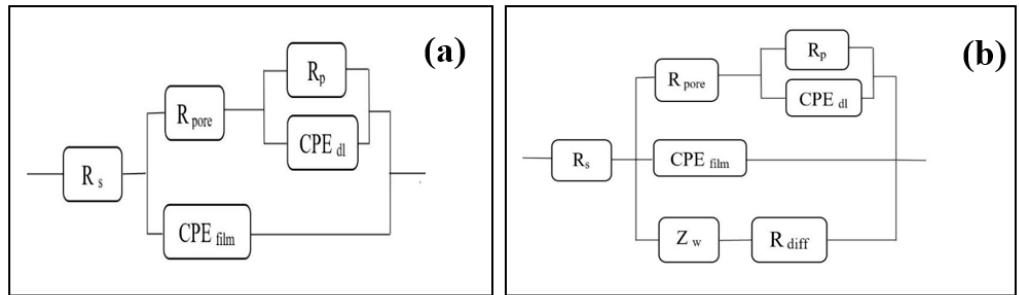
Figure 10. Equivalent circuits proposed for fitting of EIS plots: ( a ) model for single corrosion mechanism of pitting corrosion; ( b ) model for double corrosion mechanism of pitting corrosion. Table 2. The fitting parameters of EIS in neutral NaCl by the proposed equivalent circuit (EC) in Figure 9a,b.